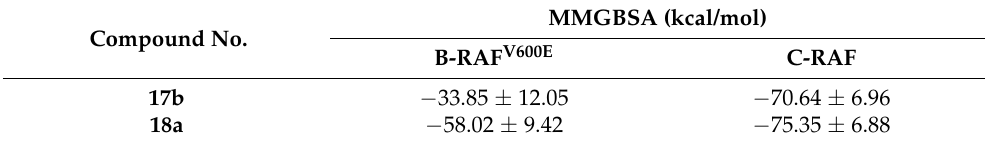
Table 5. Calculated binding free energy of compounds 17b and 18a against B-RAF V600E and C-RAF. Compound